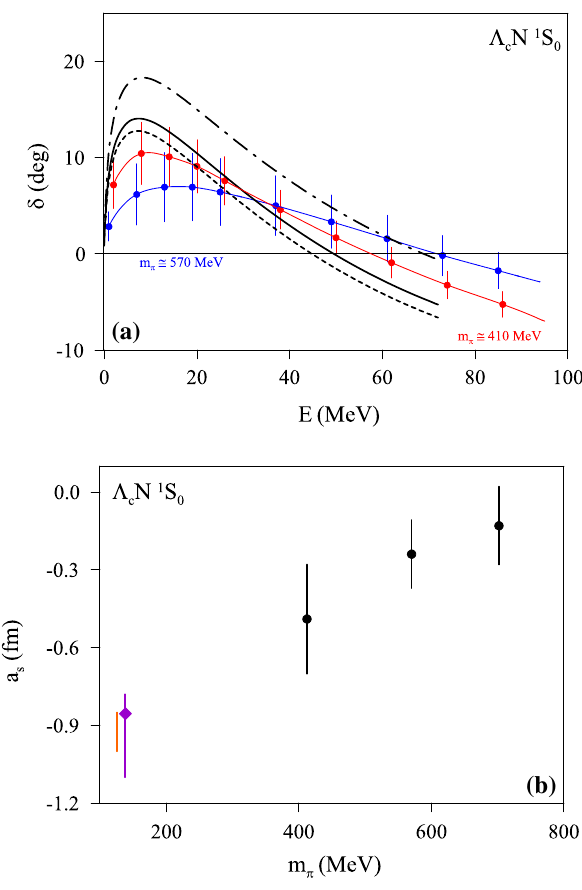
Fig. 4 a Phase shifts for the (cid:2) c N 1 S 0 partial wave as a function of the c.m. kinetic energy. The black solid line stands for the prediction of the CQM for b c = 0 . 5 fm, the dashed-dotted for b c = 0 . 2 fm, and the dotted line for b c = 0 . 8 fm. The blue (red) filled circles represent the results of the HAL QCD Collaboration [44] at m π = 570 ( 410 ) MeV. The vertical line at each point represents the statistical error of the lattice QCD simulation. The solid blue and red lines are just a guide to the eye. b Dependence of the HAL QCD (cid:2) c N 1 S 0 scattering length on the pion mass [44]. The vertical bars include statistical and systematic errors. The purple diamond represents the prediction for the physical pion mass of the CQM with the uncertainty associated to the range of values of b c chosen in ( a ). The orange vertical line stands for the range of values of the EFT extrapolation of Ref. [46] at the physical pion mass